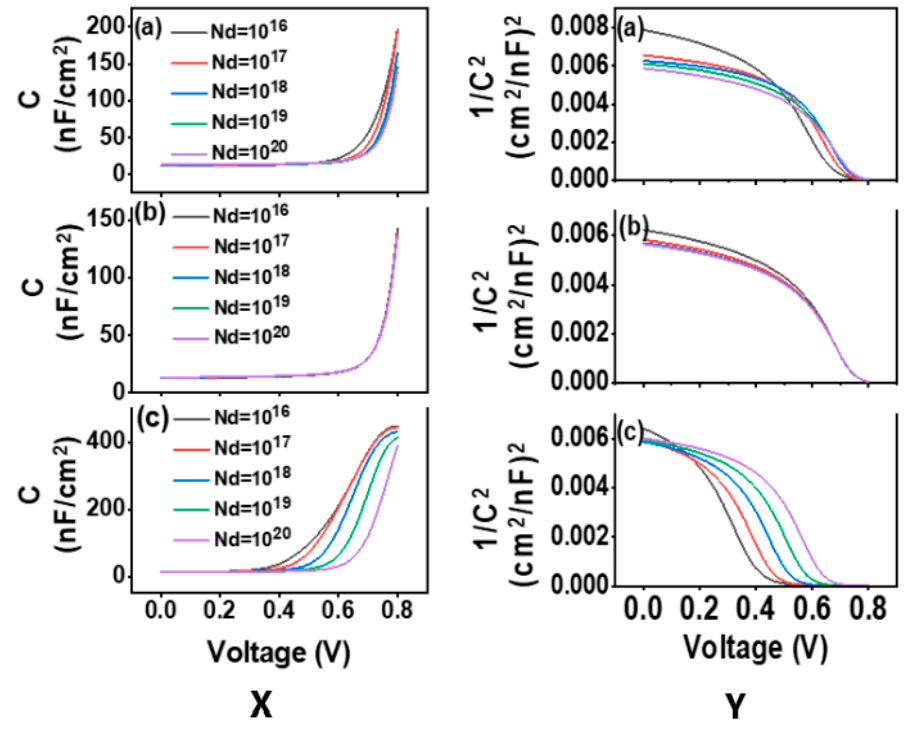
Figure 7. ( X ) Capacitance–voltage characteristics, ( Y ) Mott-Schottky plot for the PCSs, ( a ) Structure 1, ( b ) Structure 2, ( c ) Structure 3, measured as a function of ETL donor density.